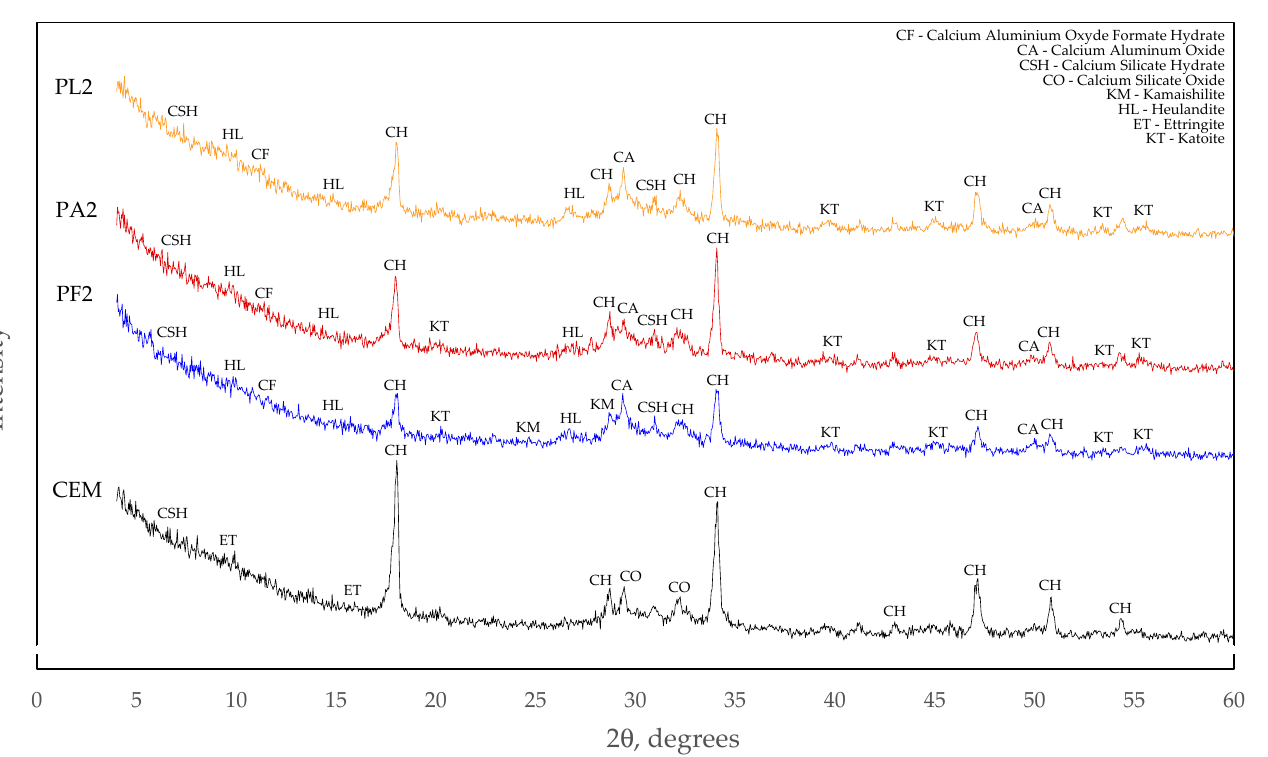
Figure 7. Results of the mechanical properties tests of mortars No 2: ( a ) after 28 days; ( b ) after 90 days.